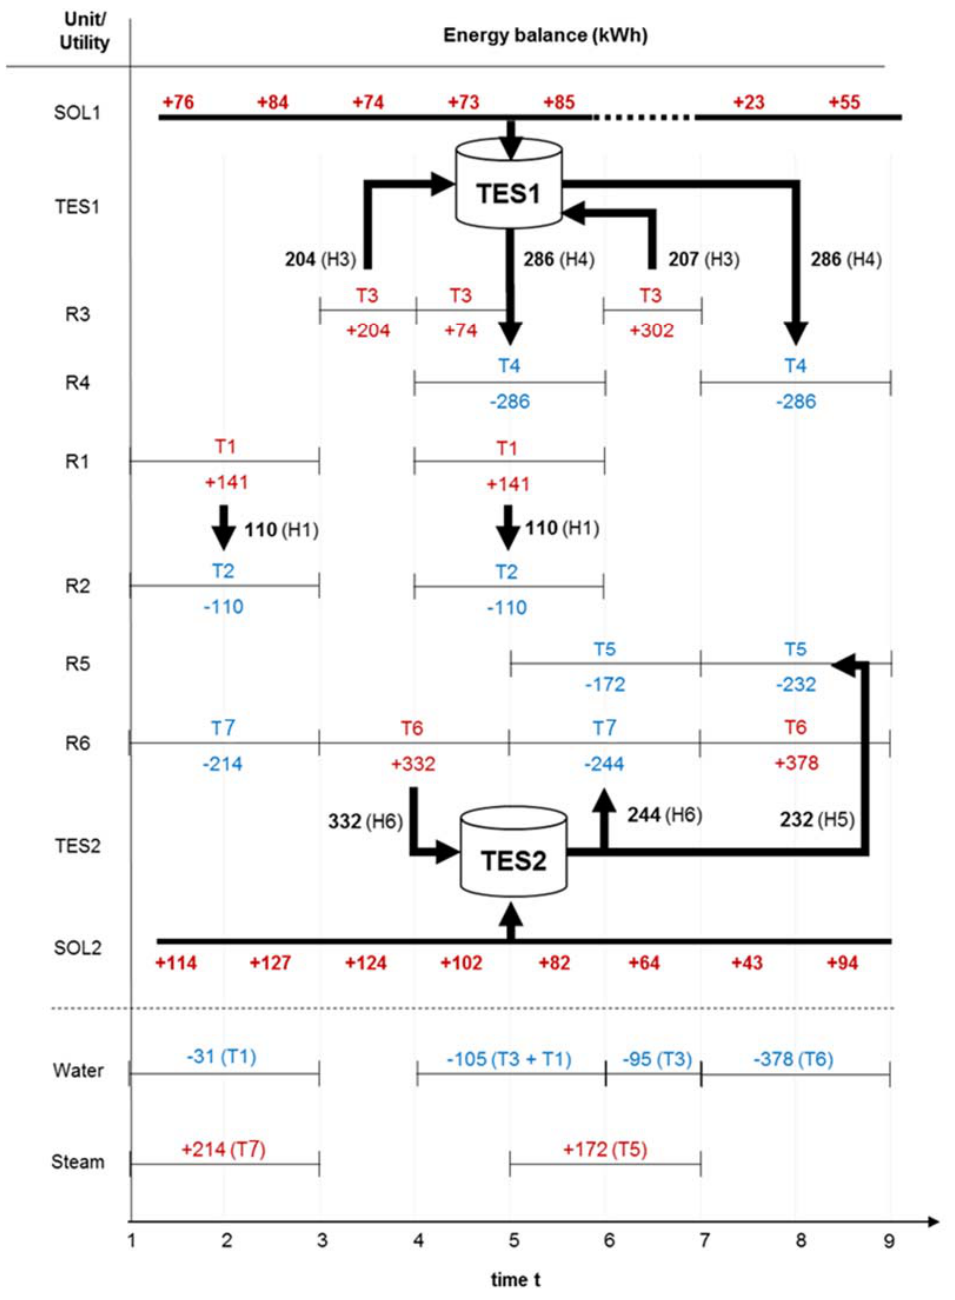
Figure 13. Energy profile.